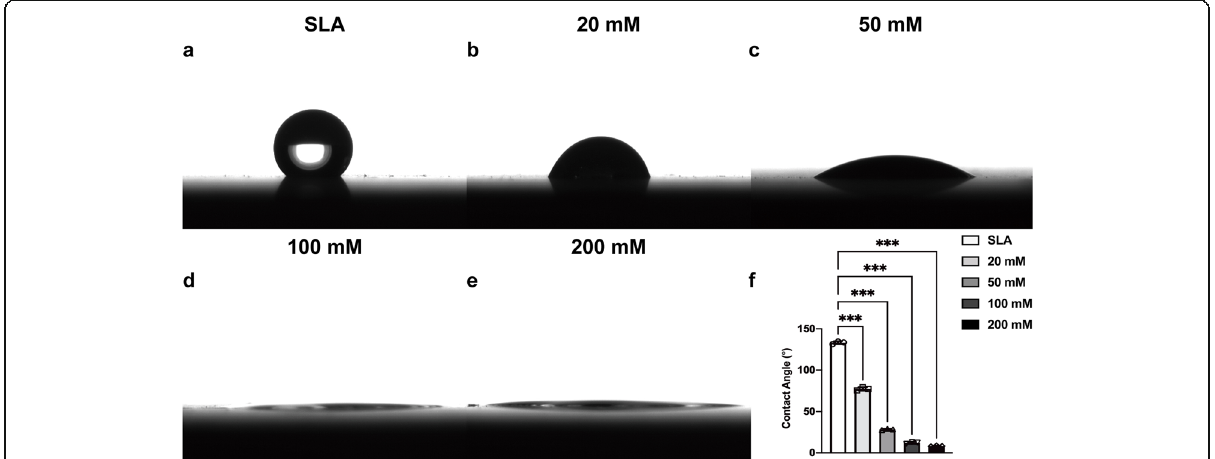
Fig. 3 Water contact angle (WCA) images of a 10 휇 L distilled water drop on SLA ( a ), 20 mM sodium bicarbonate@SLA ( b ), 50 mM sodium bicarbonate@SLA ( c ), 100 mM sodium bicarbonate@SLA ( d ), and 200 mM sodium bicarbonate@SLA discs ( e ). Quantitative results of the WCA of each group ( f ). Data are presented as the mean ± standard deviation ( n = 3, * P < 0.05; ** P < 0.01; *** P < 0.001).